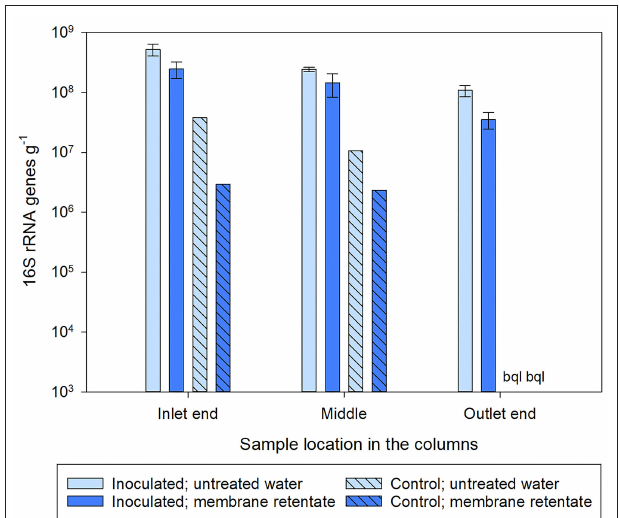
FIGURE 6 | Number of total bacteria determined by detection of the 16S rRNA gene on the sand sampled from different locations within the columns at experimental termination. Columns received during operation a feed of either untreated water with 0.3 µ g l − 1 BAM (light blue bars) or membrane retentate water with 3.0 µ g l − 1 BAM (dark blue bars). For the columns inoculated with Aminobacter sp. MSH1 data are presented as means ( n = 3) with error bars showing standard error. Two control columns were run without initial inoculation (hatched bars; n = 1). bql: below quantification